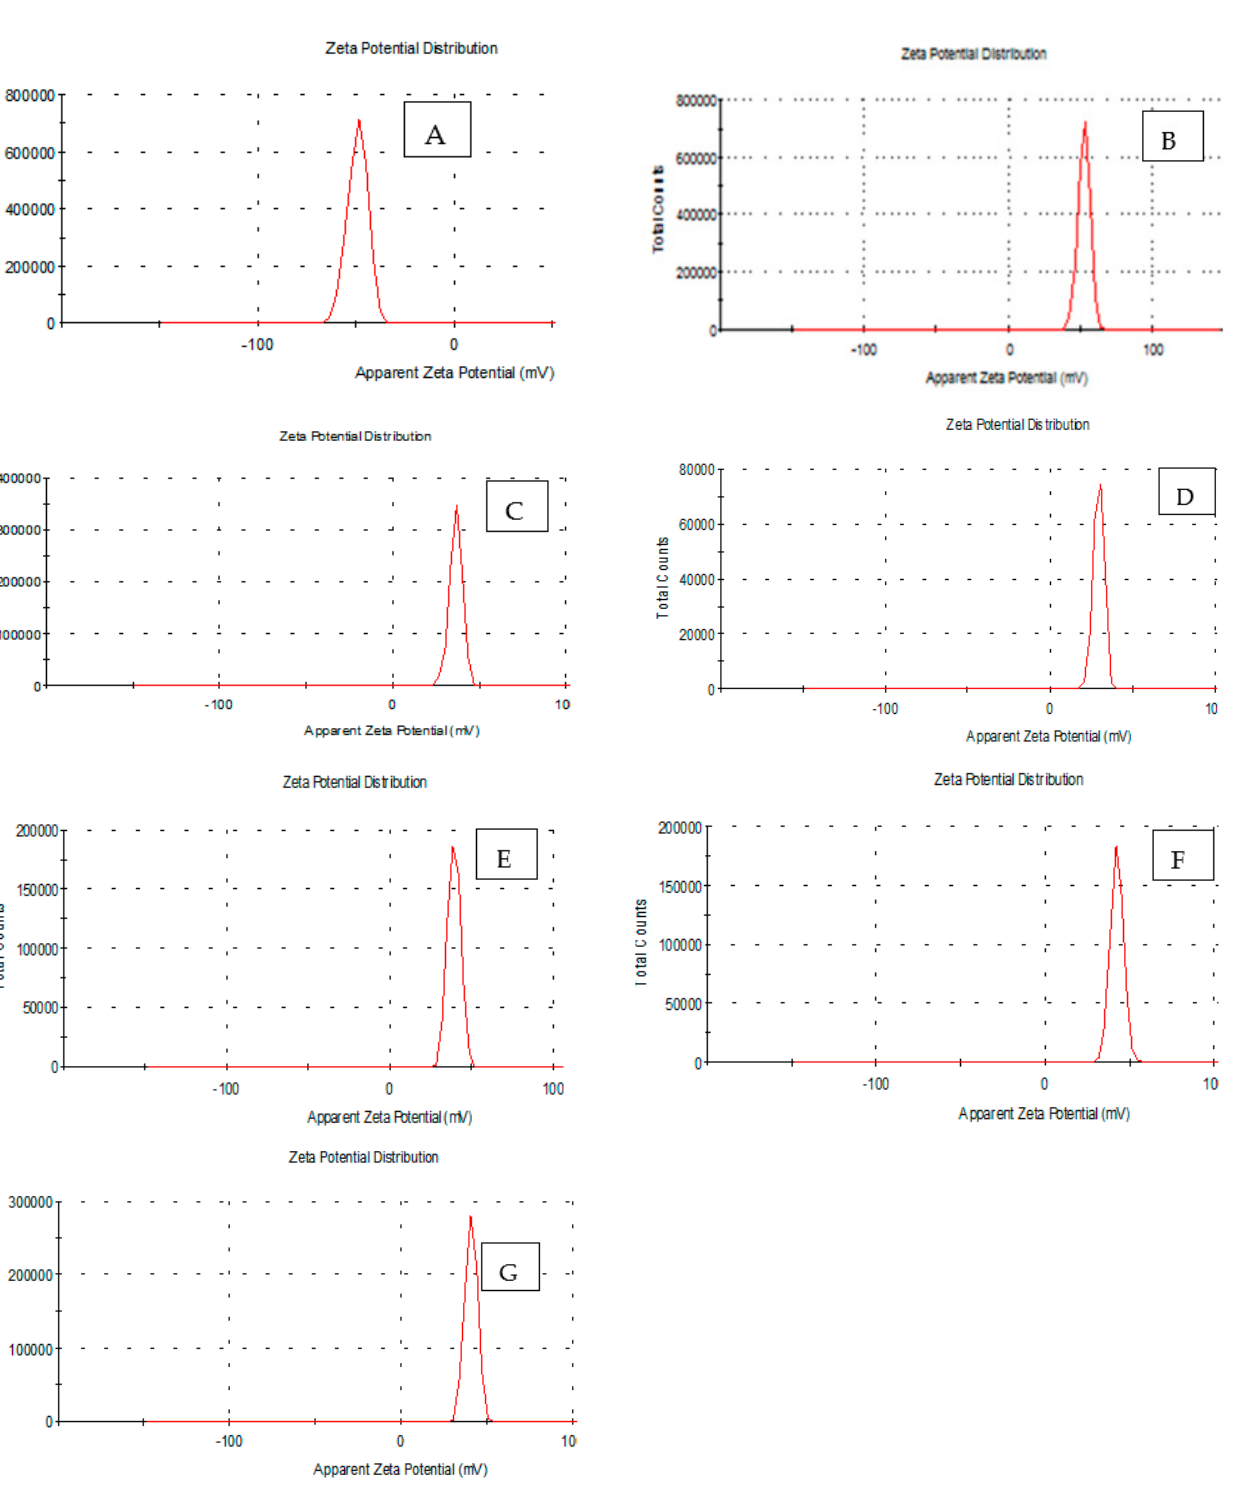
Figure 3. Zeta potentioal of prepared nano edible coatings and films combined with ZnONPs and ZnONPs/EPP to produce an edible film-forming suspension solution of different treatments. ( A ) = PPE extracts, 5% (0.1%) wt% chitosan ( B ) = ZnONPs, 1% (0.02%) wt% chitosan ( C ) = ZnONPs, 2% (0.04%) chitosan ( D ) wt% = ZnONPs, 3% (0.06%) wt% chitosan weight ( E ) = ZnONPs 1%/PPE1% (0.02%) ZnONPs 2%/PPE2% (0.04%) chitosan weight ( F ) chitosan weight ( G ) = ZnONPs 3%/PPE3% (0.06%) Chitosan weight n.s. stands for “not significantly”.